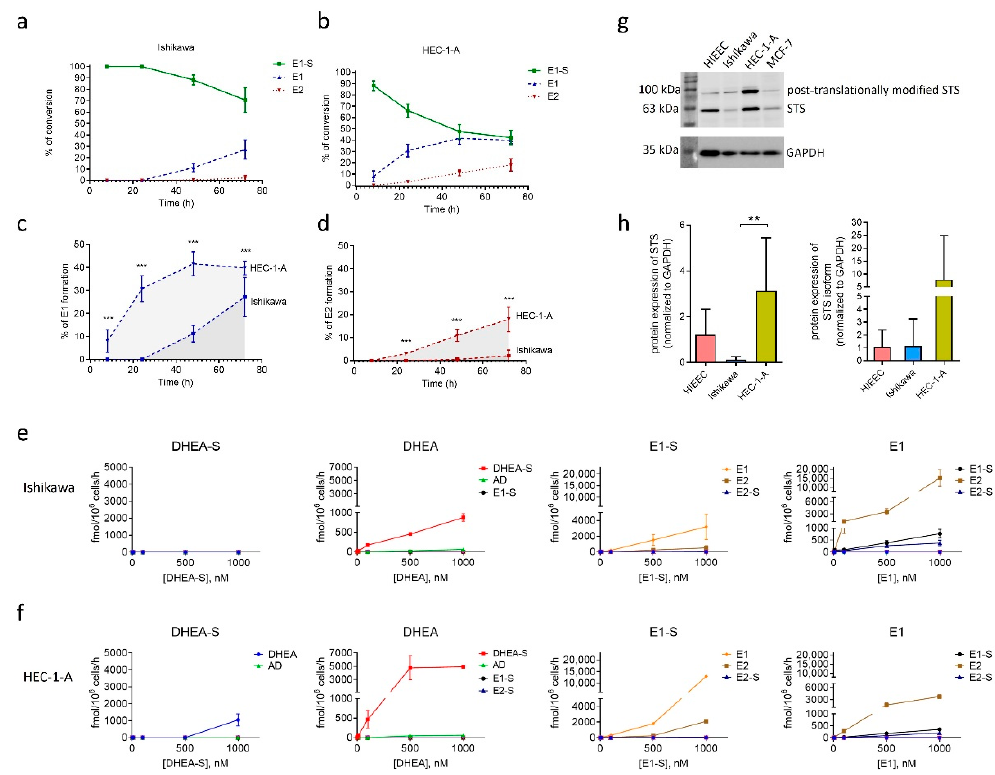
Figure 3. Metabolism of E1-S by Ishikawa and HEC-1-A cell lines evaluated using HPLC and LC-HRMS. Formation of metabolites E1 and E2 by Ishikawa ( a ) and HEC-1-A cells ( b ) after incubation with 16 nM [ 3 H]E1-S was evaluated by HPLC. The levels of individual metabolites formed after 8 h, 24 h, 48 h and 72 h are shown as percentages (%) of total products. Comparison of E1-S metabolism to E1 ( c ) and E2 ( d ) in HEC-1-A compared to Ishikawa. Three independent experiments (Mann–Whitney U test). ( e , f ) Formation of metabolites (AD, DHEA, DHEA-S, E1, E1-S, E2 and E2-S) was evaluated by LC-HRMS in medium of Ishikawa and HEC-1-A cells 48 h after addition of 10, 100, 500 or 1000 nM DHEA-S, DHEA, E1-S or E1 in two replicates for individual treatment. ( g ) STS protein levels in HIEEC, Ishikawa, HEC-1-A and a positive control MCF-7. Cropped sections of one representative membrane are shown. The full-length coomassie-stained gels, Ponceau S-stained membranes, full-length membranes after chemiluminescent detection of STS and GAPDH, and densitometric readings are presented in Supplementary File, Figure S1. ( h ) STS levels in cell lines HIEEC, Ishikawa and HEC-1-A. GAPDH was used as a loading control. The levels of STS were determined in four independently isolated protein samples from four cell lines. Western blot was repeated independently two times. The levels of STS in each sample were normalized to its loading control. One-way ANOVA with Bonferroni’s Multiple Comparison test was used to determine statistical significance. Data are shown as mean ± SD. ** p -value ≤ 0.01, *** p -value ≤ 0.001.